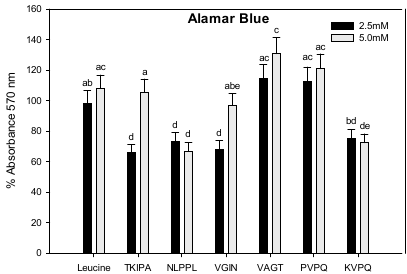
Figure 1. Cell viability of C2C12 (8 × 10 4 cells/well) treated with synthesized peptides for 24 h, measured with the Alamar Blue assay. Experiments were performed in triplicate. Different letters indicate significant difference ( p < 0.05).